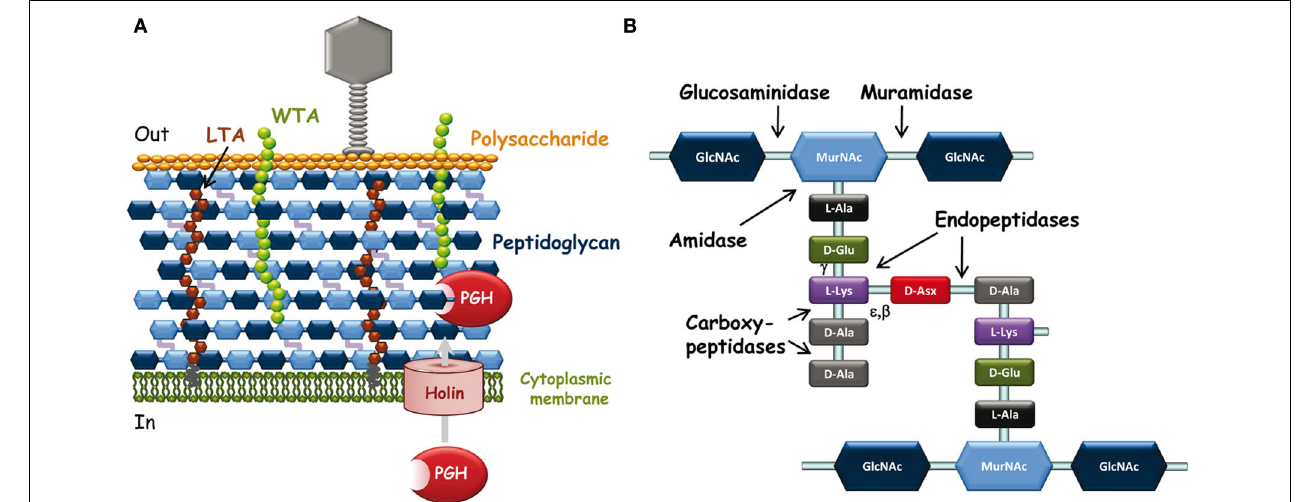
FIGURE 1 | (A) Schematic representation of L. lactis cell wall and its interactions with infecting bacteriophages. Outside the bacterial cell, phages adsorb to bacteria through specific recognition of receptors (polysaccharide on this scheme) located at the bacterial surface. Inside the bacterial cell, at the end of the infection cycle, endolysin and holin encoded by the phage genome are synthesized to lyse bacteria and release phage progeny. Endolysins are PG-hydrolases that gain access to their substrate by passing through pores made by oligomerization of holins. (B) Schematic peptidoglycan structure. Structure with D-Asx cross-bridge (A4 α -chemotype) is found in L. lactis and in several Lactobacillus species. Asx stands for Asp or Asn. The third amino acid of